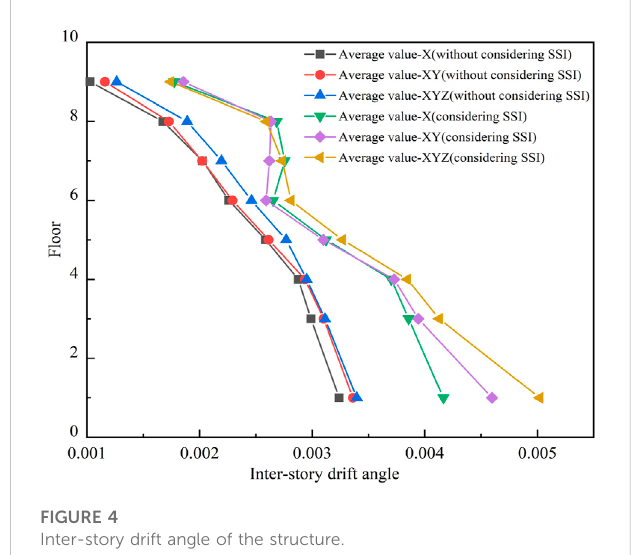
FIGURE 4 Inter-story drift angle of the structure.